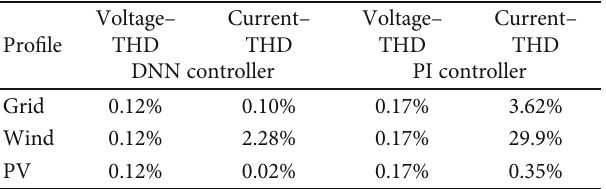
Figure 39: THD values of microgrid load voltage. Table 4: Comparative analyses of THD values, grid, wind, and